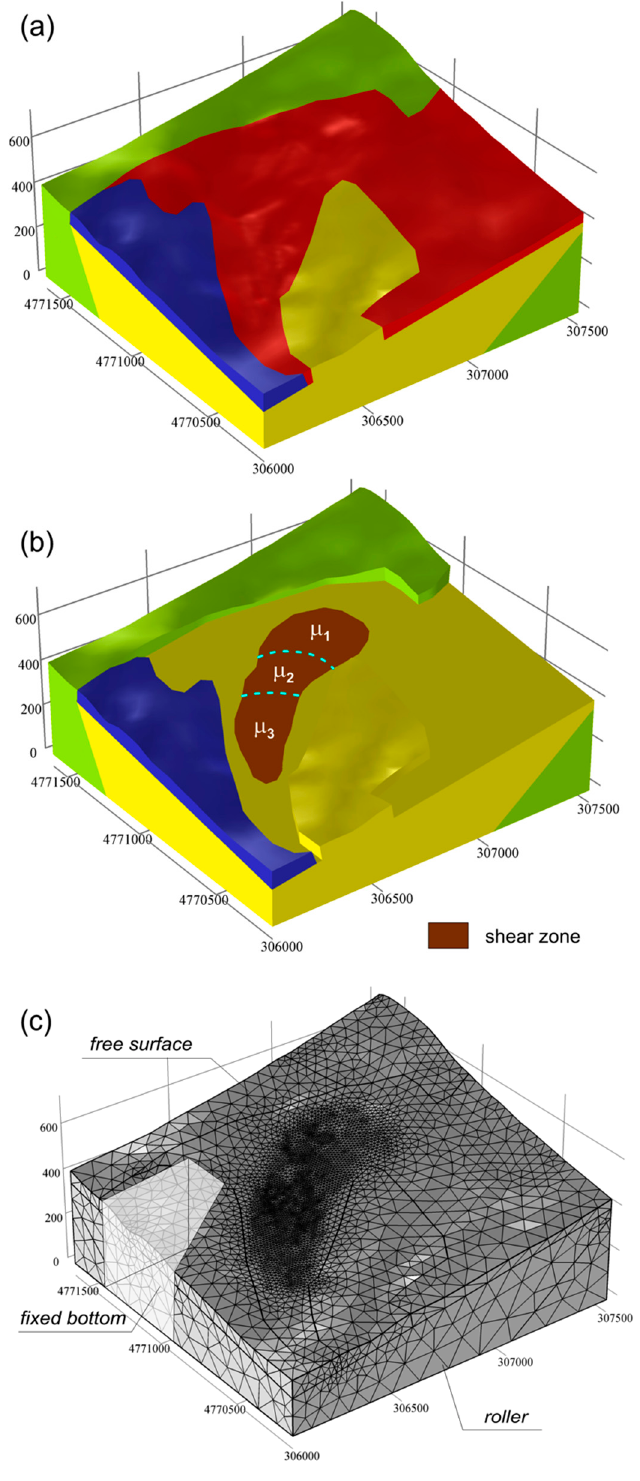
Figure 4. 3D FE Model: ( a ) Simplified geological model exploited in the FE environment; for each domain we report in Table 1 the physical and mechanical parameters relevant to the different lithologies, reported in Figure 2a; Panel ( b ) highlights the shear domain. The three sectors with different values of viscosity ( μ ) are also shown; the corresponding values are reported in Table 2; ( c ) Discretized numerical domain with the boundary conditions: fixed and roller ones.